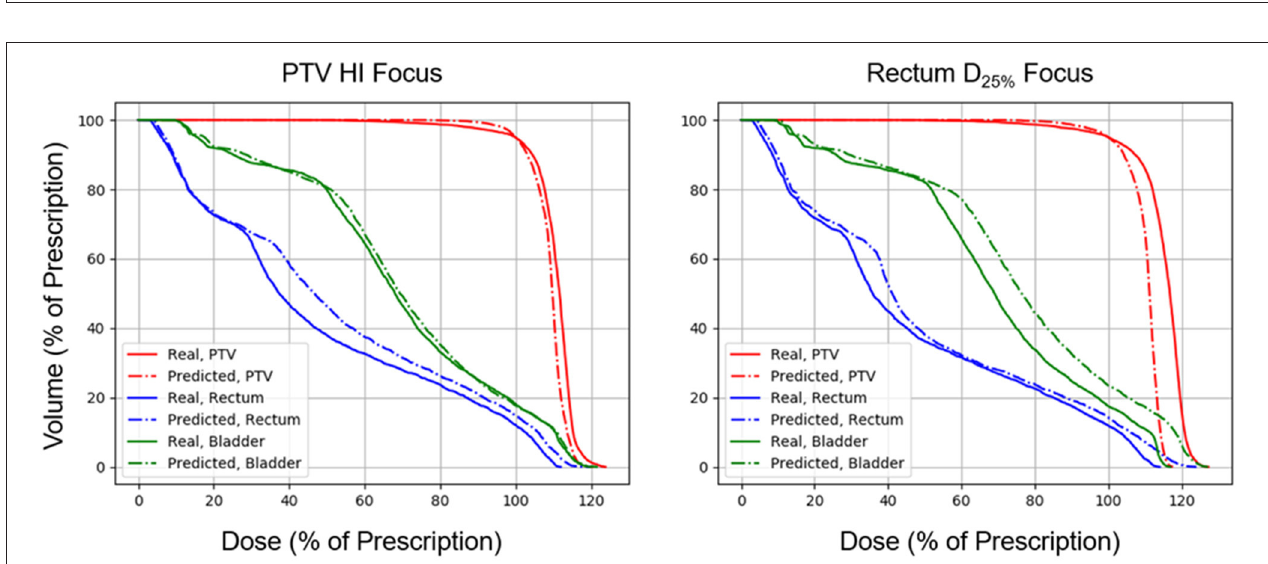
FIGURE 6 | Side-by-side comparisons between the effect of prioritizing PTV HI or prioritizing rectum D 25 % in a DVH prediction and its corresponding TPS-simulated DVH.